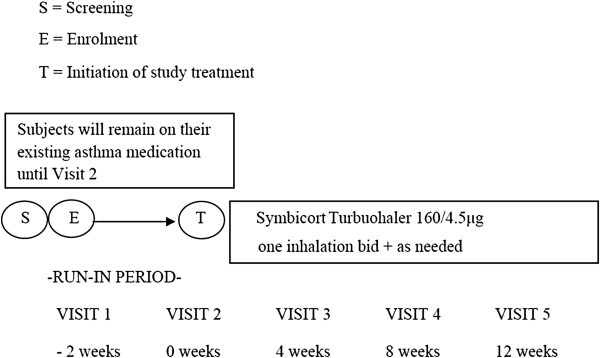
Study flow chart.